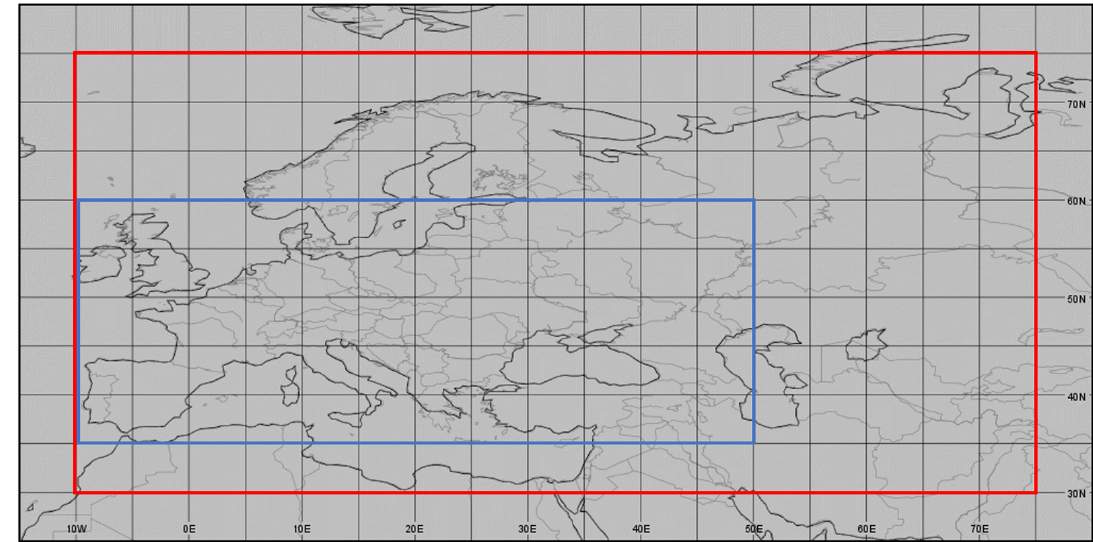
Figure 5. Regions covered by the dataset in this paper: “Europe and North Africa”, targeted by this study (in red, Section 3.1). “Europe” for comparison with [16] (in blue, Section 3.2).